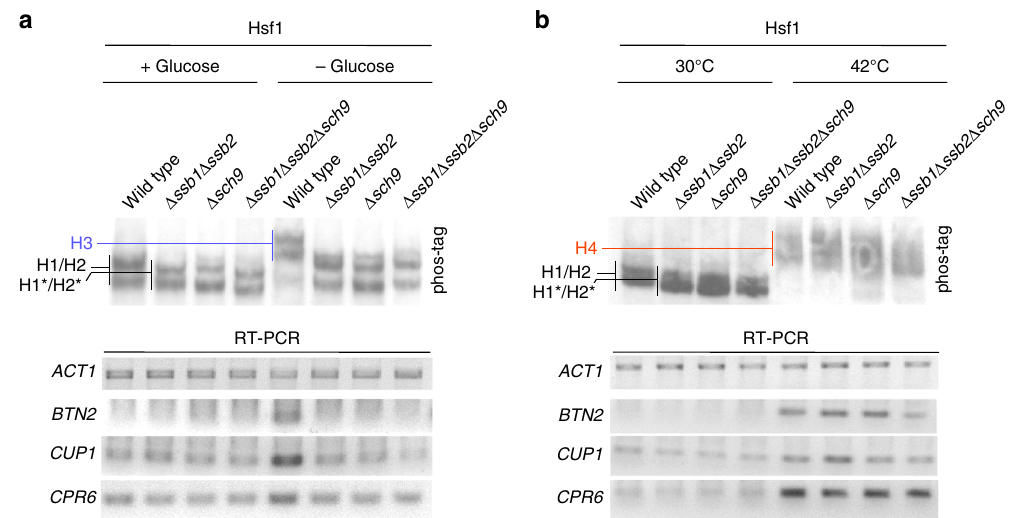
Fig. 6 Phosphorylation of Hsf1 by Sch9 is required for Hsf1 activation upon glucose depletion but is not required for Hsf1 activation upon heat shock. a , b Total protein or total RNA was prepared from glucose-grown, glucose depleted, or heat shocked (42 °C, 15 min) cells as described in Methods section. Analysis of Hsf1 phosphorylation was performed as described in Fig. 5. H4: hyper-phosphorylated Hsf1 species formed upon heat shock. RT – PCR for the genes indicated was performed with total RNA. Actin ( ACT1 ) levels were used as a loading control. Glucose starvation in RT – PCR experiments was 30 min to allow for the expression of a detectable amount of Hsf1-induced transcripts. The Hsf1 – H3 species was stable during a 30 min glucose depletion time course (Supplementary Fig.